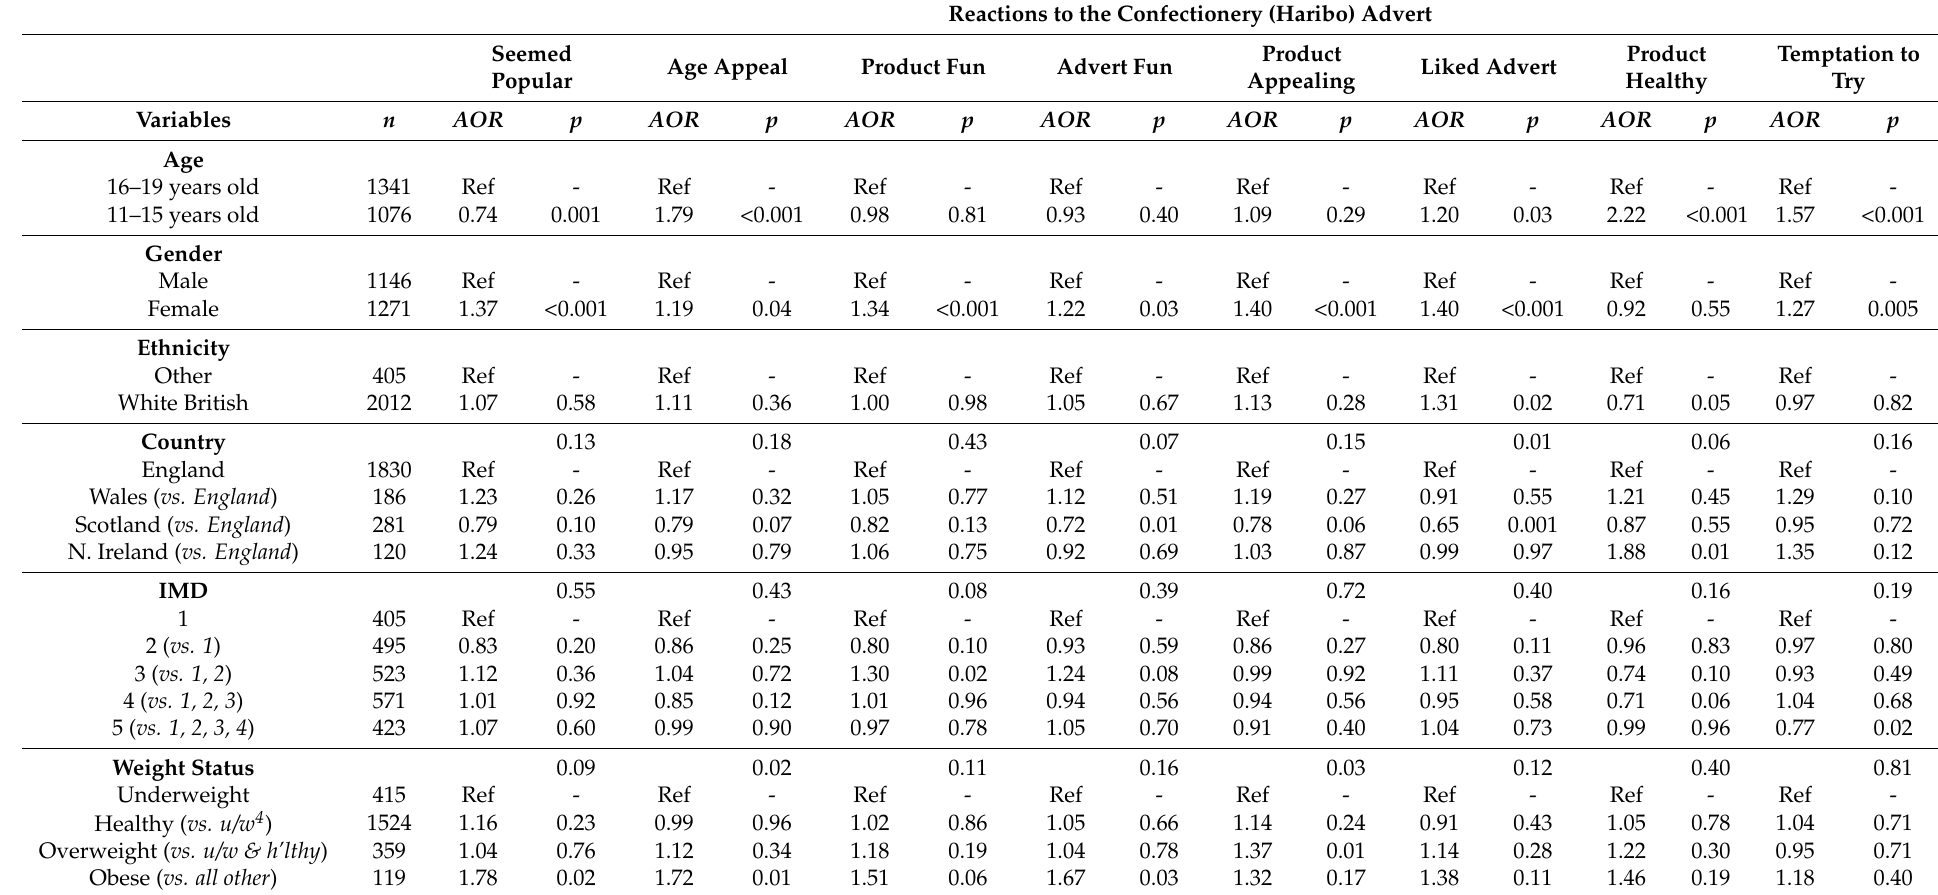
Table 5. Reactions to the confectionery advert and associations with demography and the BMI